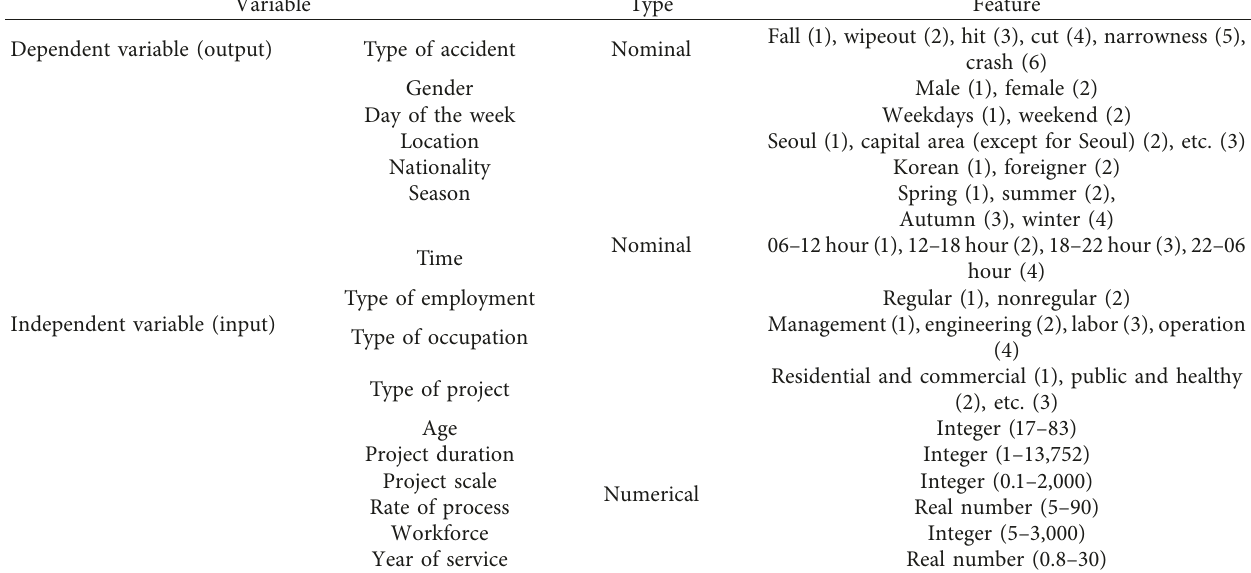
Table 2: Factors of construction accidents on-site.